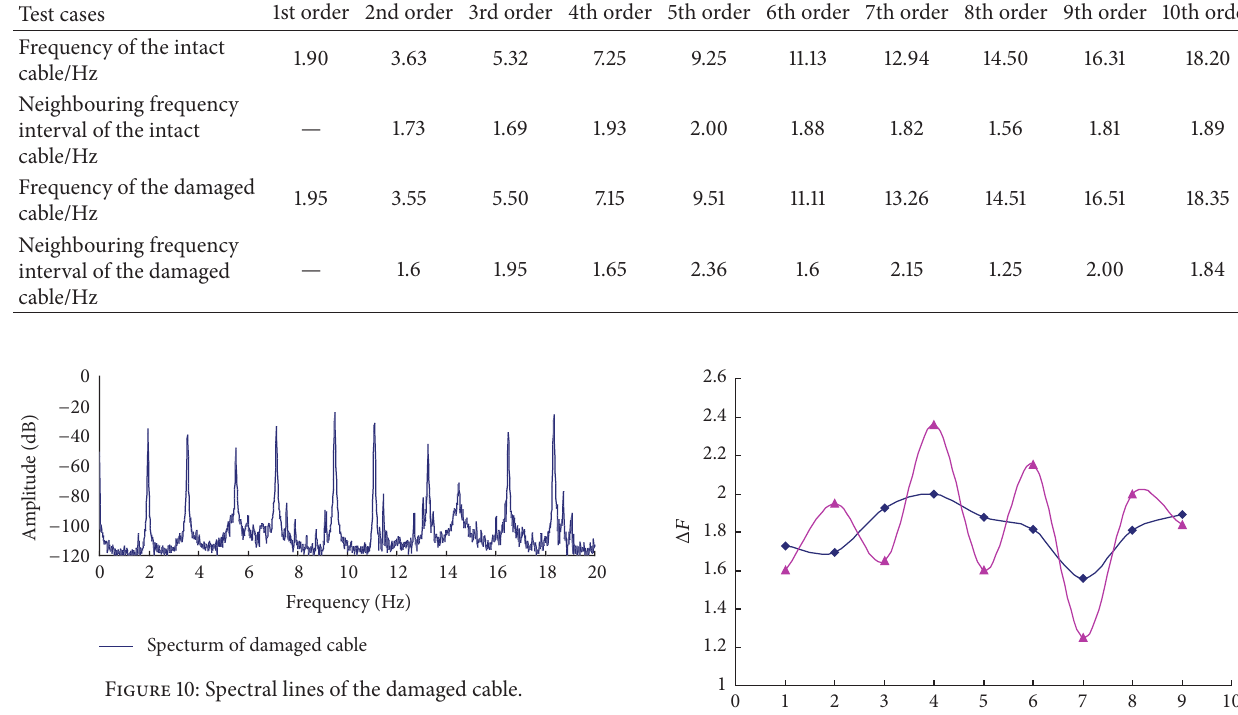
Table 1: Frequencies of the inclined cables.